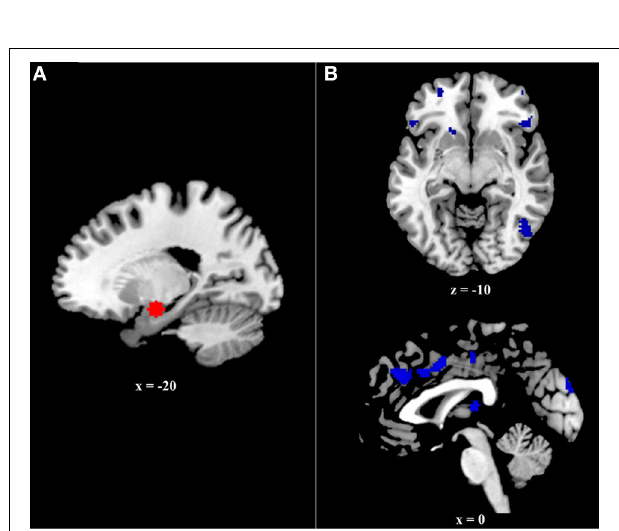
FIGURE 2 | (A) Six millimeter sphere used as the volume of interest (VOI) for psychophysiological analysis. The center of this VOI ( − 20, − 8, − 16) was selected via an omnibus contrast that identified regions associated with retrieval (Hits > Correct Rejections) of all events (positive, negative, and neutral), controlling for age. VOIs were created and defined functionally at the single-subject level. (B) Regions exhibiting greater age effects on the relation between functional and structural connectivity during positive event retrieval relative to negative event